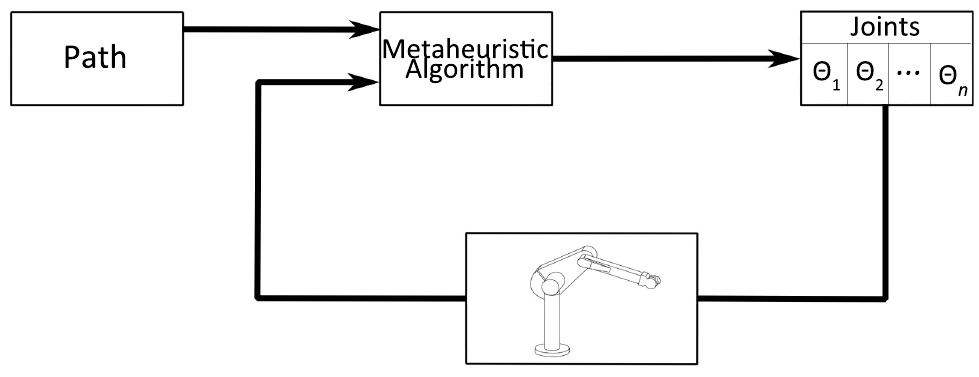
Figure 3. Schematic representation of the path tracking problem for manipulator